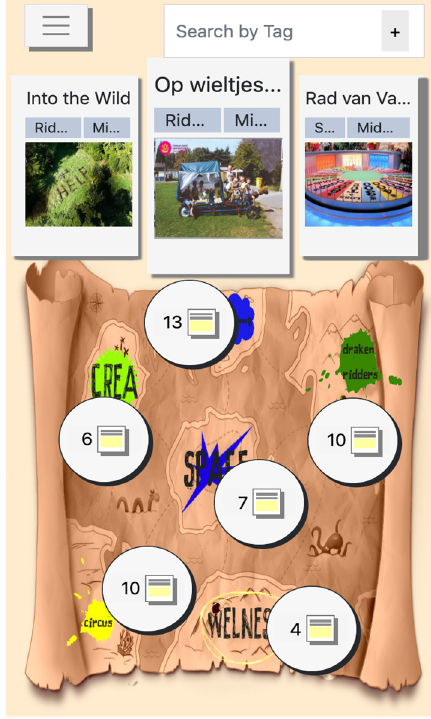
Figure 10. Treasure map used for the first evaluation with VDS.